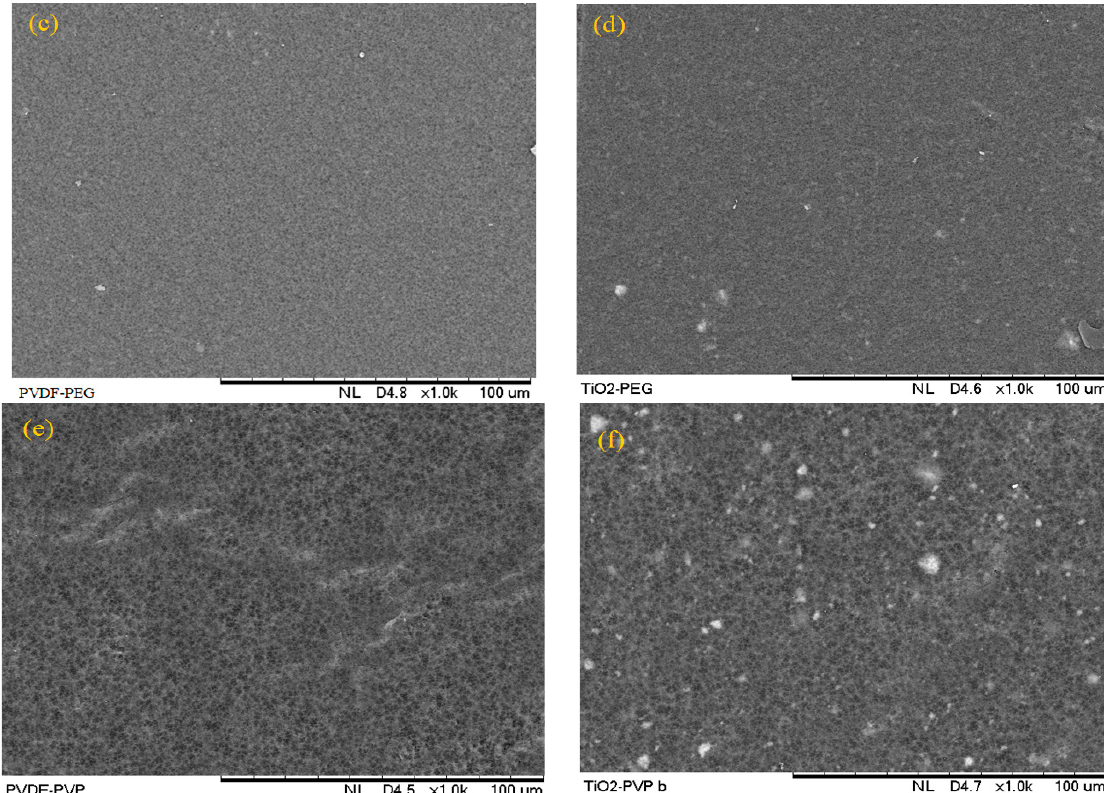
Figure 3. SEM micrographs the surface morphology of membranes: ( a ) pristine PVDF, ( b ) PVDF–TiO 2 , ( c ) PVDF–PEG, ( d ) PVDF–TiO 2 -PEG, ( e ) PVDF–PVP, ( f ) PVDF–TiO 2 -PVP.